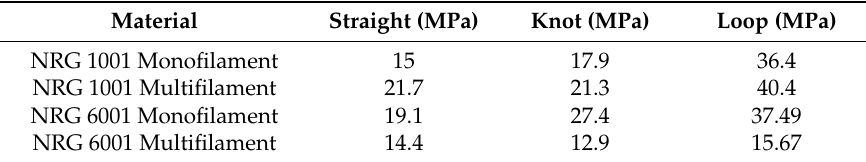
Table 7. Average yield strength.